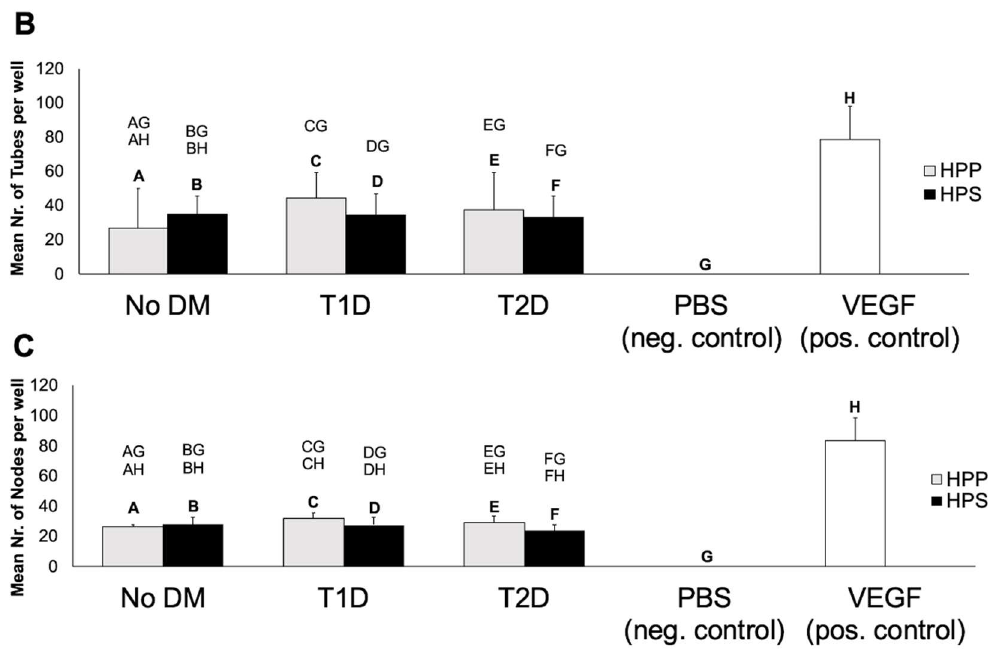
Figure 6. E ff ects of hypoxia preconditioned blood-derived secretomes obtained from diabetic subjects on microvessel formations in human umbilical vein endothelial cell (HUVEC) cultures in vitro. ( A ) Panel showing representative images of the tube formation assay (12 h), carried out in the presence of hypoxia preconditioned plasma and serum (HPP and HPS) obtained from subjects su ff ering from type 1 (T1D) or type 2 (T2D) diabetes, as well as nondiabetic subjects (no DM) (Bars = 200 µ m). ( B ) Plots showing the mean number of tubes and ( C ) nodes formed in HUVEC cultures that were incubated for 12 h with HPP and HPS samples obtained from the above test conditions. Capital letter pairs over plots indicate statistical comparisons of the corresponding data points. For all pair comparisons, p < 0.05, unless otherwise indicated. Error bars represent s.d.; number of subjects tested: no DM, n = 8; T1D, n = 6; T2D, n = 10; PBS, n = 3; and VEGF, n = 3. Three samples were tested per subject per condition.